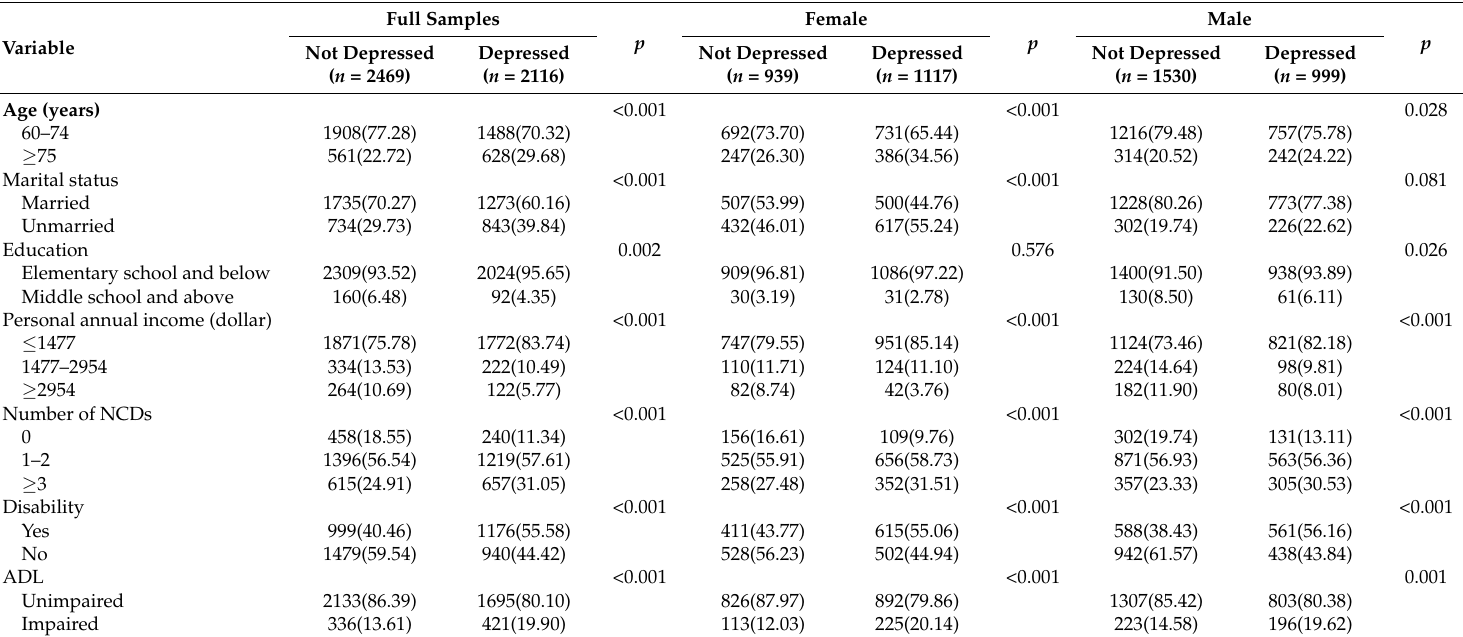
Table 1. Distribution and prevalence of depressive symptoms by gender according to participant characteristics.